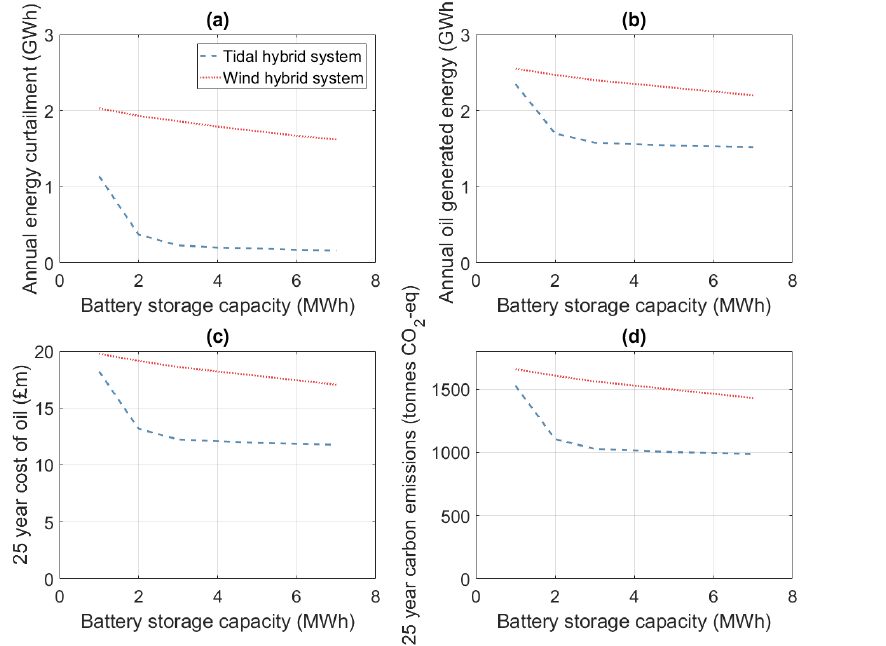
Figure 11. Relationship between battery storage duration and ( a ) annual turbine energy curtailment, ( b ) annual dependency on oil generators, ( c ) 25 year oil cost and ( d ) 25 year carbon emissions (CO 2